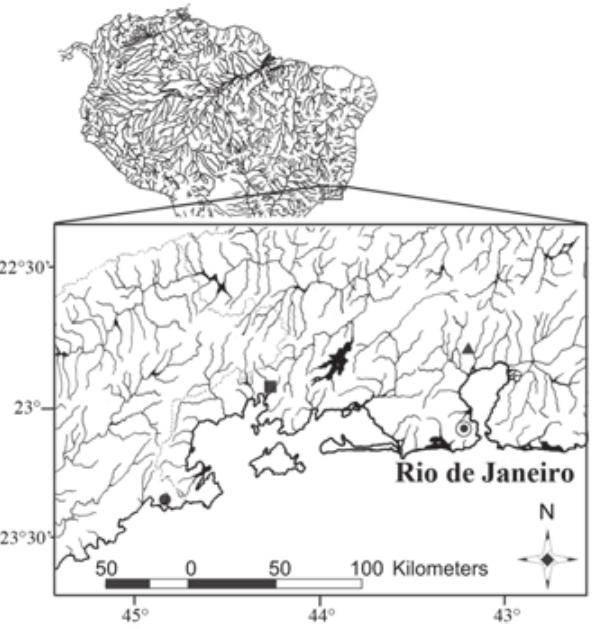
Fig. 7. Geographic distribution of Listrura costai, new species (square), and putatively more related valid species L. picinguabae (circle) and L. nematopteryx (triangle); southeastern Brazil. Dashed lines indicate the frontiers among São Paulo (west), Rio de Janeiro (east) and Minas Gerais (northwest)